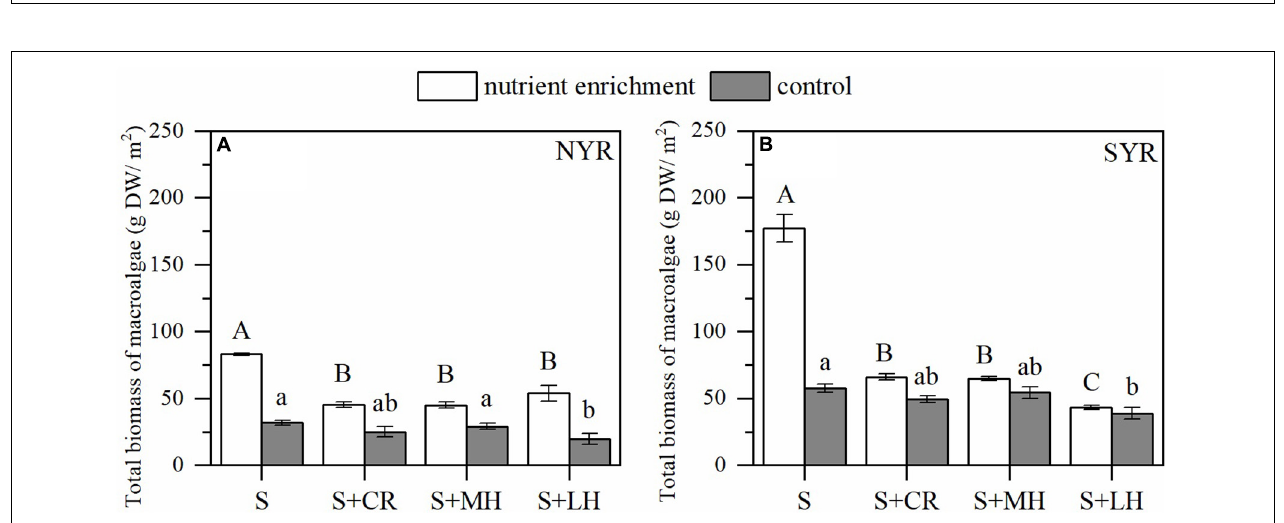
FIGURE 5 | Effects of nutrient enrichment and herbivory on the total biomass of macroalgae in the NYR (A) and SYR (B) (mean ± SE, n = 4). Within nutrient treatments (enrichment or control), bars sharing a letter are not significantly different from one another ( p > 0.05).